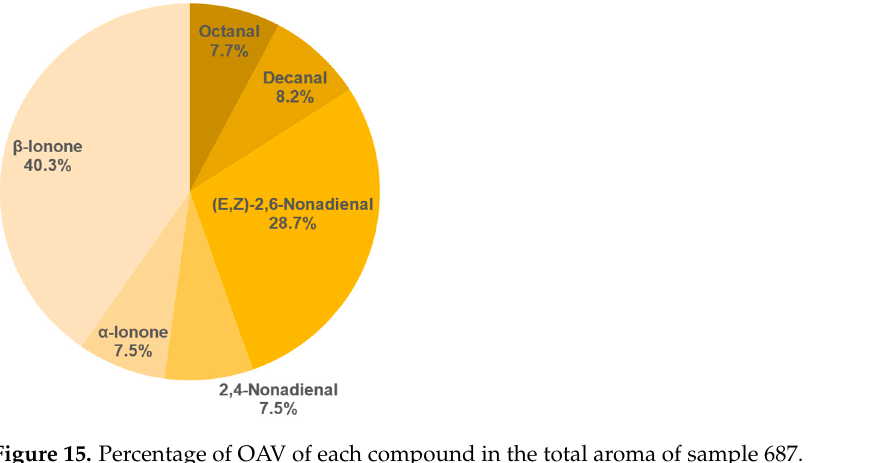
Figure 16. Percentage of OAV of each compound in the total aroma of sample 234.